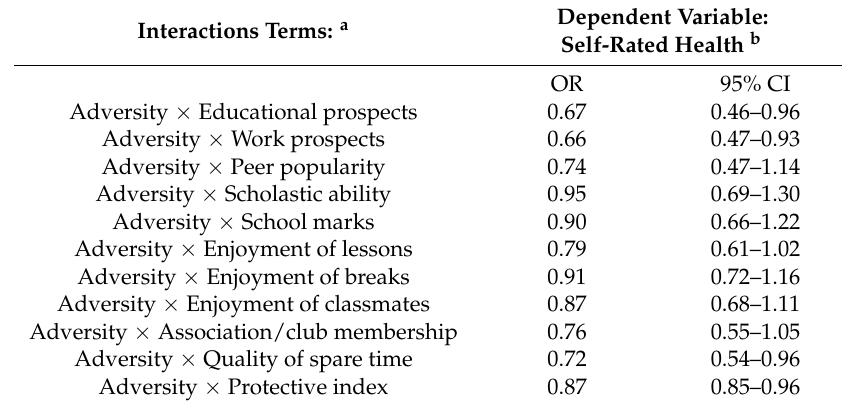
Table 4. Interactions between social and material adversity and the protective factors at T1 (age 16) in their effect on self-rated health at T2 (age 43). Results from ordinal regression analysis, presented as odds ratios with p -values ( n = 908). Adjusted for gender, internalising symptoms, and functional somatic symptoms at